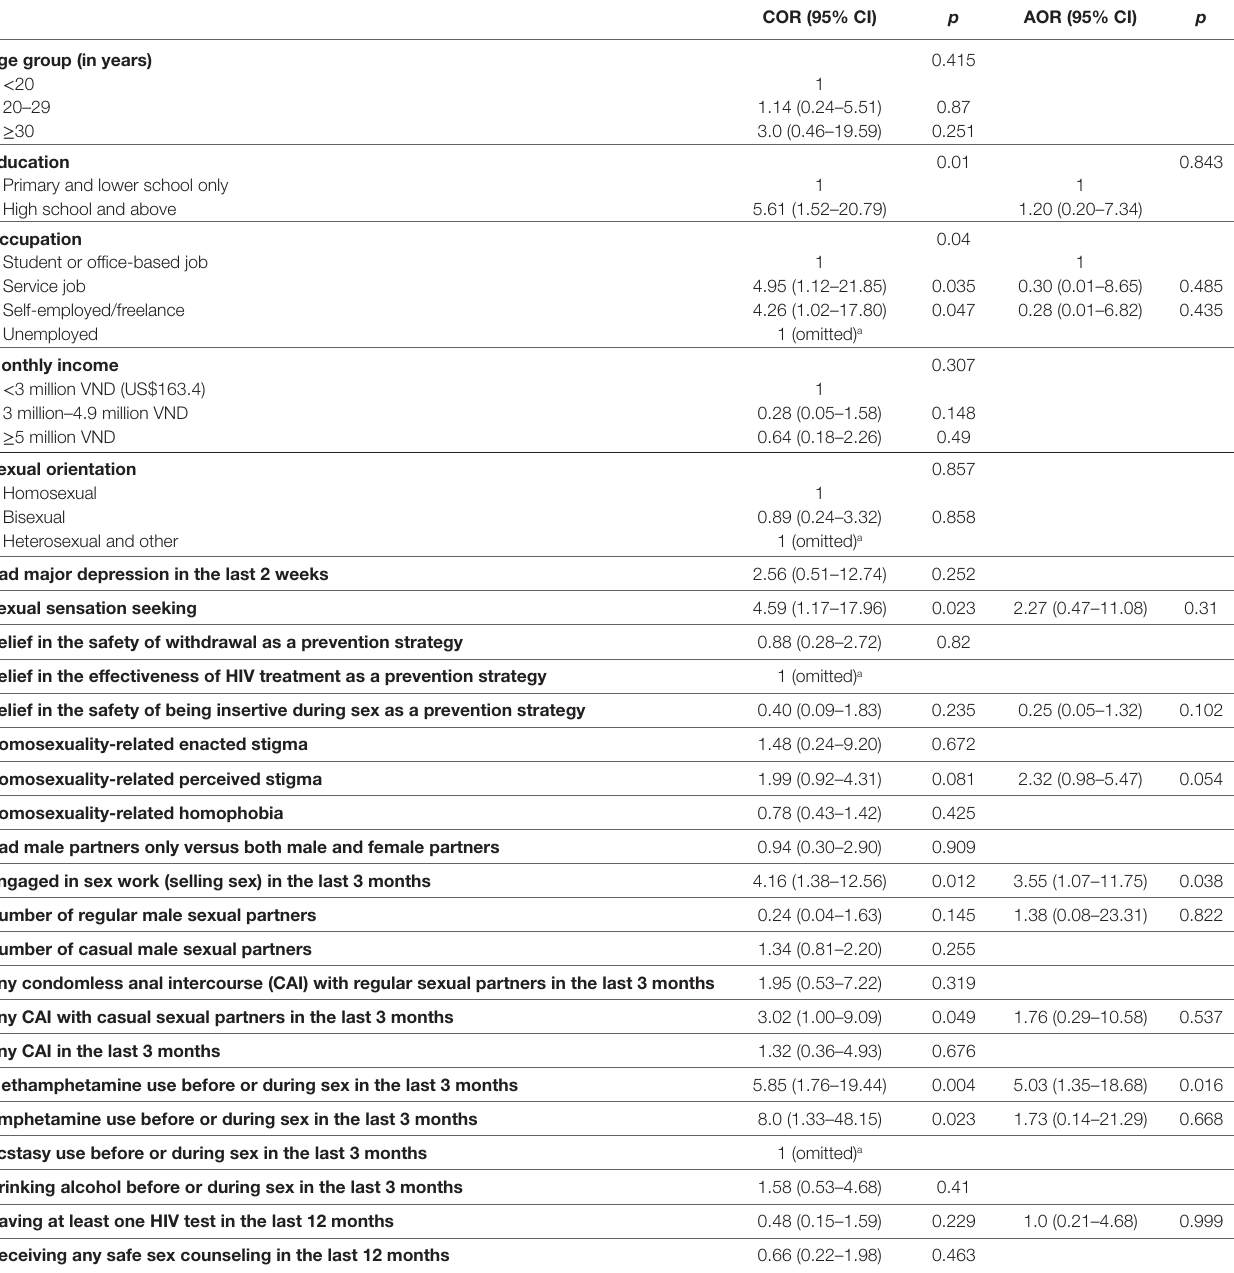
TaBle 3 | Bivariate and multivariate analysis of associations with hiV infection ( N =